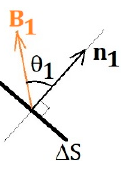
Figure 9. Unit normal vector n 1 at the pond bottom and unit direction vector B 1 of the irregularly reflected light at the pond bottom.